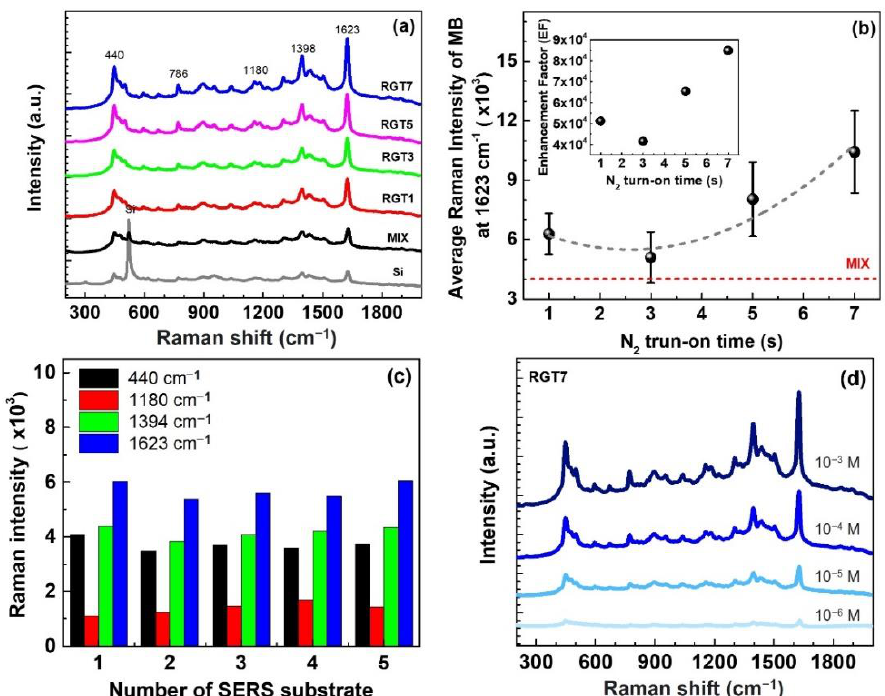
Figure 7. SERS activity of HfN thin films. ( a ) Raman spectra of MB 10 − 4 M on HfN thin films and a bare Si substrate. ( b ) Raman intensity of MB at a Raman shift of 1623 cm − 1 . Inset is enhancement factor value. ( c ) Reproducibility of RGT7. ( d ) Raman spectra of MB in the concentration range of 10 − 3 down to 10 − 6 M using RGT7 as a SERS